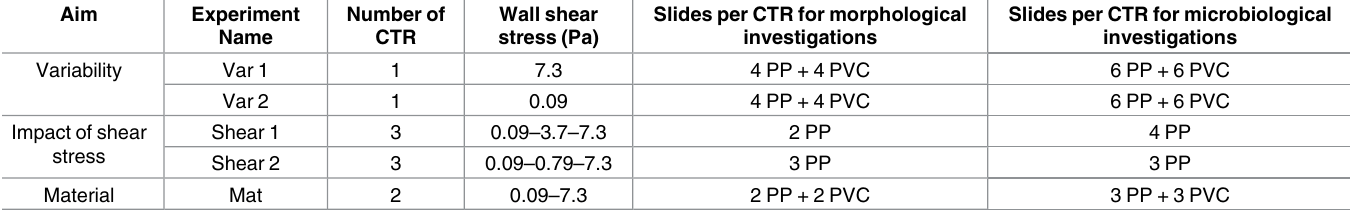
Table 2. Description of the different experiments carried out. The two right-handcolumns represent the number of slides per reactor that has been pro- cessed for morphologicalor microbiological characterization,